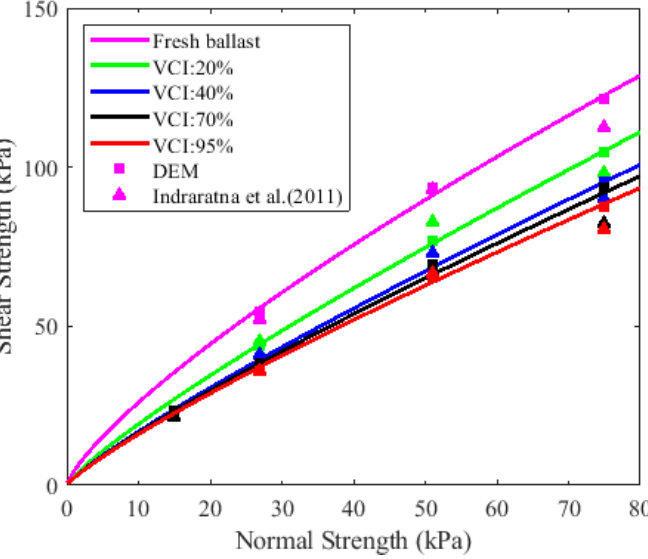
Figure 12. Normal stress versus shear strength results for different VCI ratios.